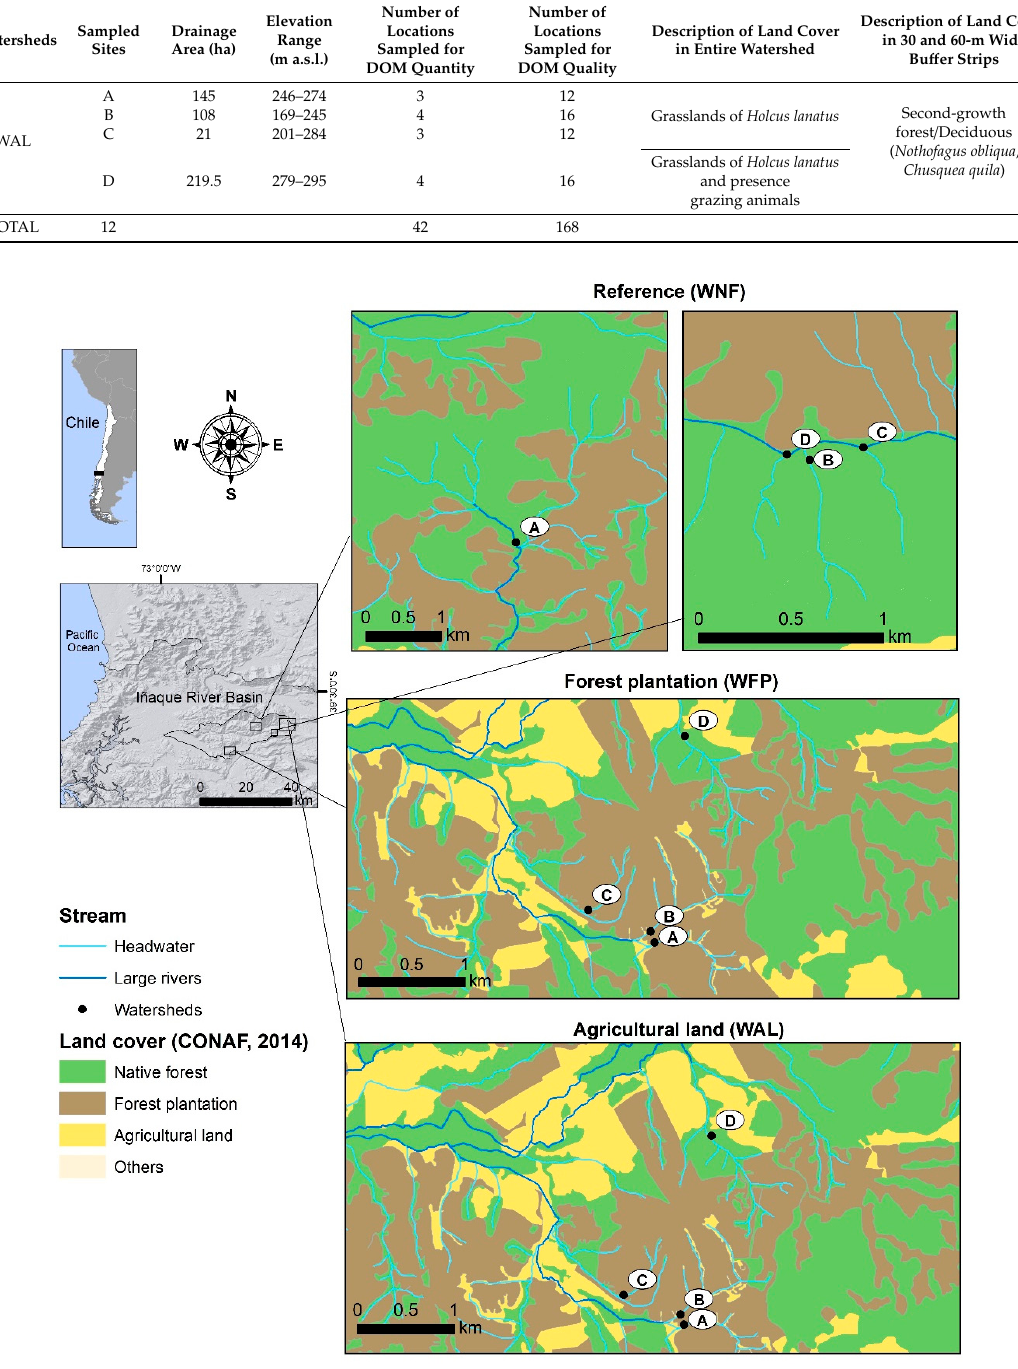
Figure 1. Map of the 12 sampled sites in the Iñaque River Basin. Letters represent watersheds dominated by native forests (WNF), forest plantations (WFP) and agricultural lands (WAL).